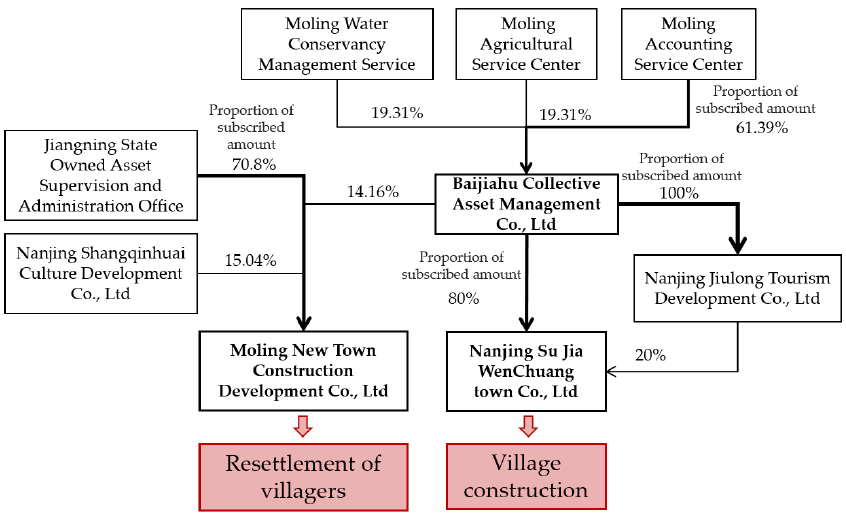
Figure 11. Collective asset management and construction platform at the Moling Subdistrict.